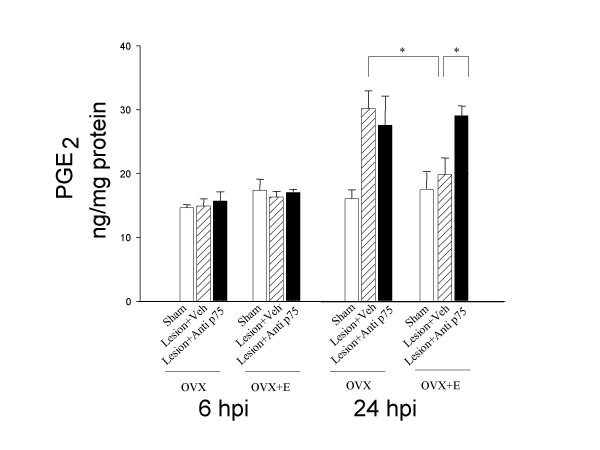
PGE2 levels in the lesioned olfactory bulb: PGE2 expression was not altered by lesion or hormone treatment at 6 h post injury (6 hpi). However, at 24 hpi, PGE2 expression increased 2-fold in the control-pellet (OVX) replaced lesioned groups, while this increase was not seen in the estrogen-treated (OVX+E) lesioned animals. However, anti-p75NTR treatment completely abolished estrogen's suppressive effects, making this group indistinguishable from the control pellet replaced, lesioned animals. Bars represent means ± SEM, n = 6 per group. Sham: Sham lesion, Lesion+Vehicle: NMDA injection with pre immune serum, Lesion+Anti p75: NMDA injections with anti-p75NTR antibodies. *:p < 0.05.